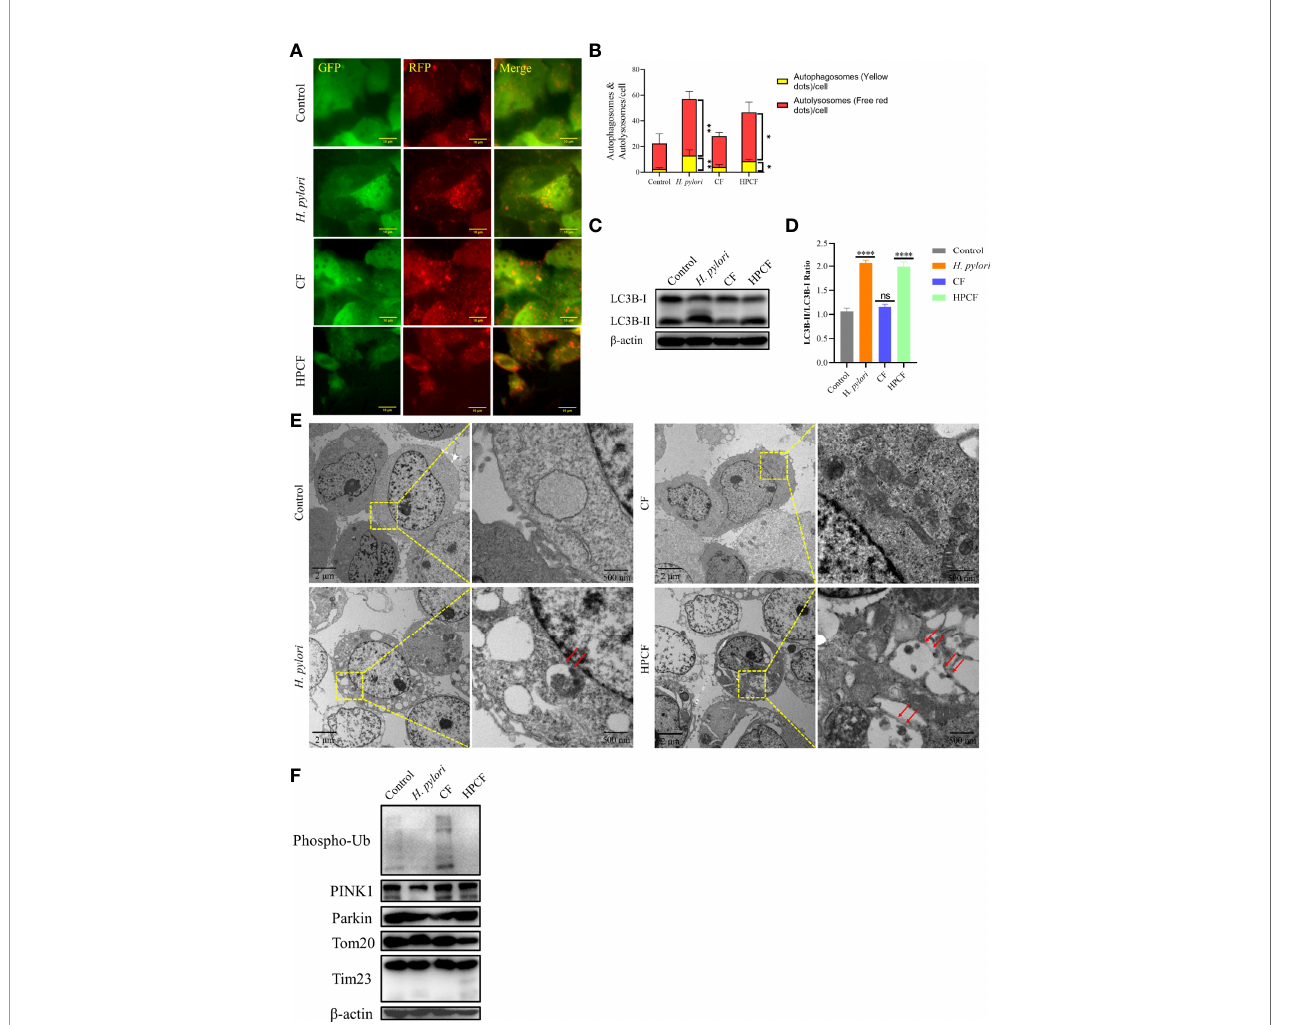
FIGURE 2 | H. pylori or HPCF induced autophagy/mitophagy in GES − 1 Cells. GES-1 mRFP-GFP-hLC3B cells were challenged with H. pylori , CF, or HPCF for 24 h, and the representative fl uorescence images (Scale bar, 10 m m) of autophagosomes (yellow dots) and autolysosomes (red dots) using the tandem mRFP-GFP-hLC3B fusion protein assay (A) . The autophagy fl ux was evaluated by the ratio of red dots to yellow dots (B) . The conversion of LC3B-I to LC3B-II was detected using western blot (C) , and the level of change was quanti fi ed (D) . Representative images (Scale bars, 2 m m and 500 nm) of autophagosomes (indicated by red arrows) in GES-1 cells using the transmission electron microscope (TEM) (E) . The expression of mitophagy-related proteins was measured by western blot (F) . The asterisks indicate signi fi cant differences from the control. n = 3. * p <0.05, ** p <0.01, **** p <0.0001. ns, no signi fi